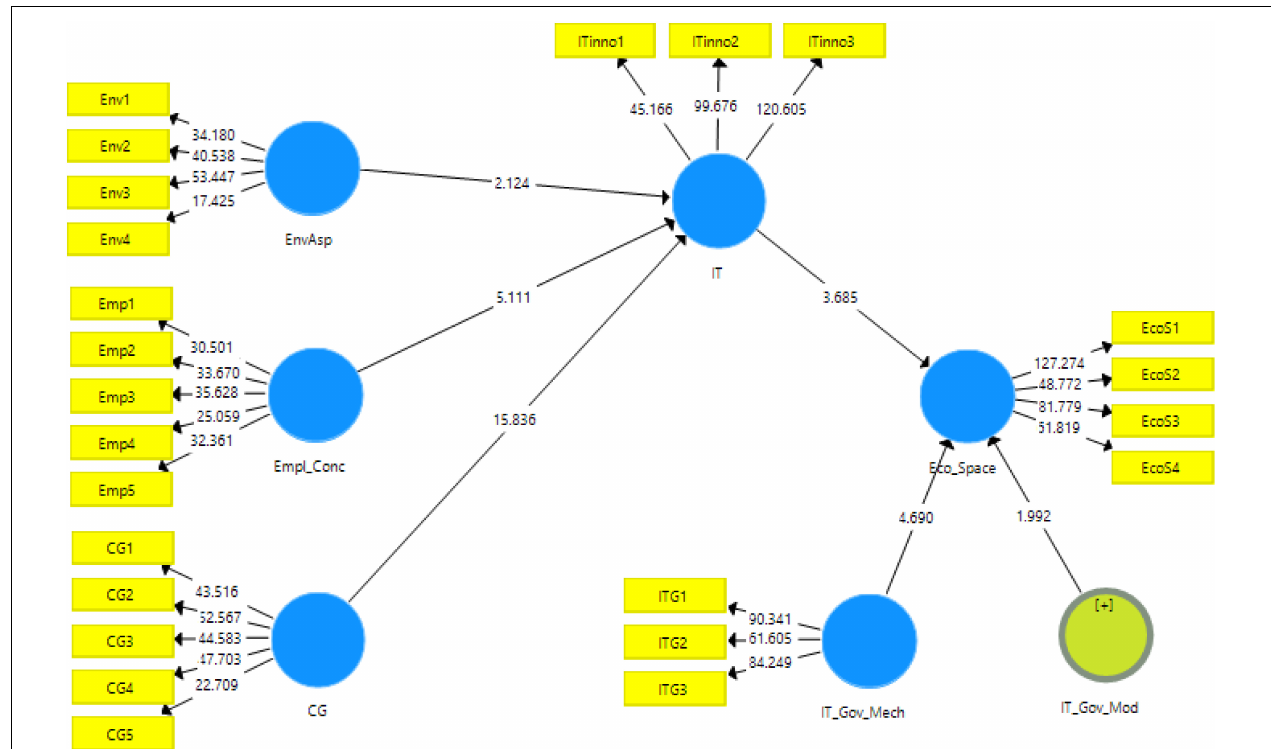
FIGURE 3 | Output of structural model algorithm. EnvAsp, environmental aspect; Empl_Conc, concern for employees; CG, ethical and corporate governance awareness; Eco_Space, sustainable economic space; IT, technological innovation; IT_Gov_Mech, IT governance mechanism.